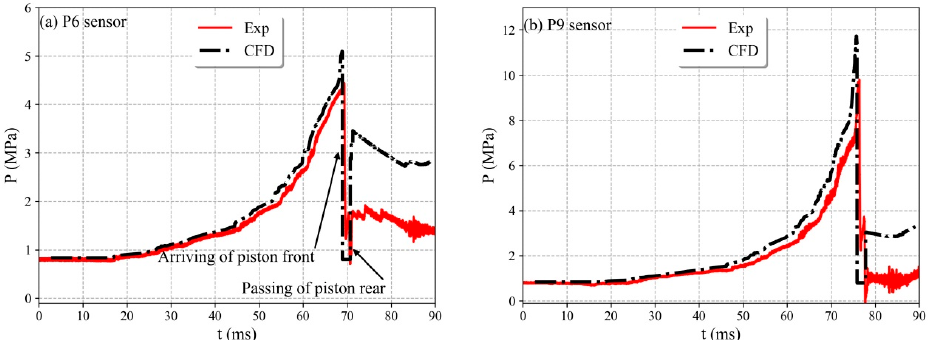
Figure 10. Pressure histories for Case 1. ( a ) P6 sensor; ( b ) P9